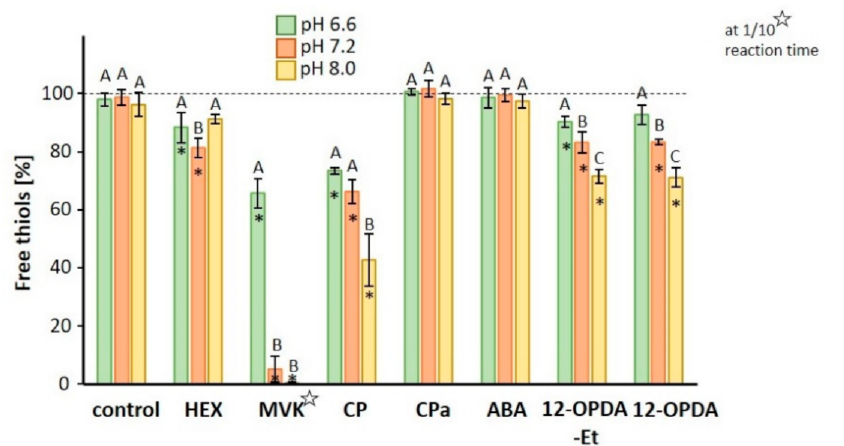
Figure 1. Reactivity of 12-OPDA and related molecules with glutathione (GSH) at three physiological pH values. 100% refers to 500 µ M GSH in the sample, 50% GSH corresponds to 250 µ M GSH being conjugated to the indicated compound in a reaction period of 30 min at 25 ◦ C. The reaction time with methyl vinylketone (MVK) was 3 min (indicated with a star). Results are presented as means ± SD (n = 6–9). Asterisks indicate a statistically significant difference between buffer control and treated samples at respective pH-values. Significant differences of treatments or buffer control between different pH-values are indicated by different letters A–C. Significance of difference ( p ≤ 0.05) was calculated using one-way ANOVA with post hoc Tukey HSD test. For details, see Section